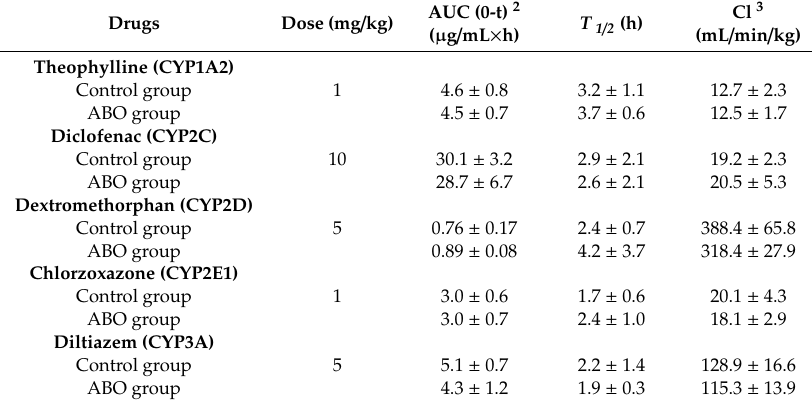
Figure 2. Plasma concentration–time profiles of the five drugs (IV doing) after administration of a single oral dose of adlay bran oil (ABO) in rats. Drug cocktail (CYP1A2: theophylline ( a ), CYP2C: diclofenac ( b ), CYP2D: dextromethorphan ( c ), CYP2E1: chlorzoxazone ( d ), CYP3A: diltiazem ( e ) was administered intravenously at a dose of 1–10 mg / kg body weight (BW) to rats 1 h after administration of control oil (soybean oil; 2.5 mL / kg BW) or ABO (2.5 mL / kg BW). Values at each time point are expressed as the mean ± SD of six rats in each group. ● : Control group; ○ : ABO group. Table 1. Pharmacokinetic parameters of five drugs (IV dosing) after the administration of a single oral dose of ABO in rats 1.